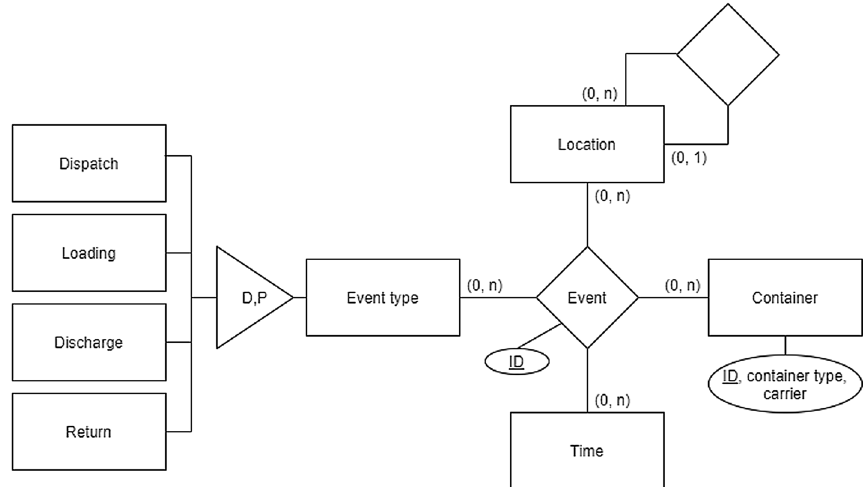
Fig. 2 Entity-relationship model of events. Source : Own